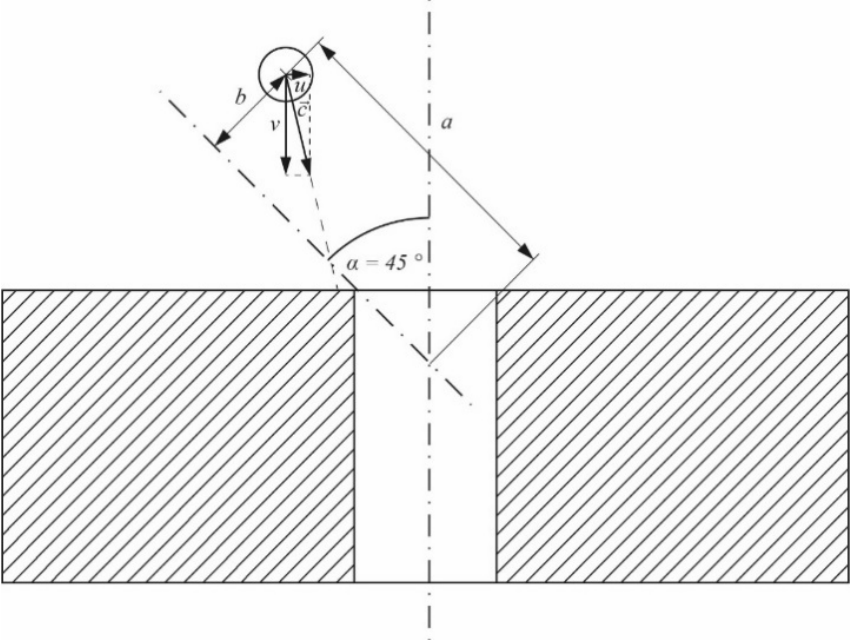
Figure 13. Position and trajectory vector c for a particle that has a high damage potential upon impact. The magnitude and direction of the velocity vectors for the critical particle position differ depending on the pressurization of the system. The components of the vectors at different operating pressures are shown in Table 4. Table 4. Components of velocity vectors at different operating pressures p for the critical particle trajectories; the velocity vector c consists of two components, i.e., in the x-direction ( u ) and y-direc- tion ( v ).